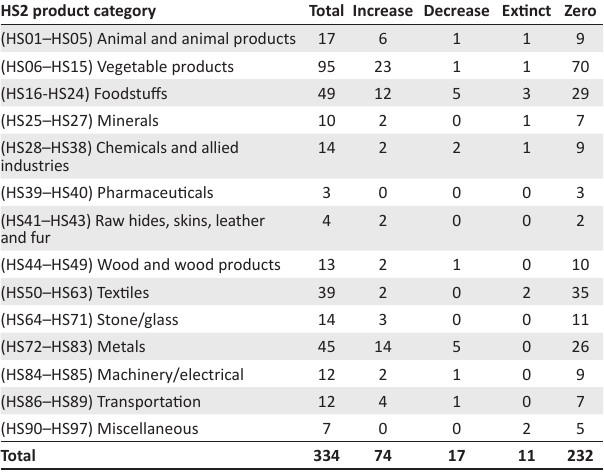
TABLE 4: Number of matches identified according to product